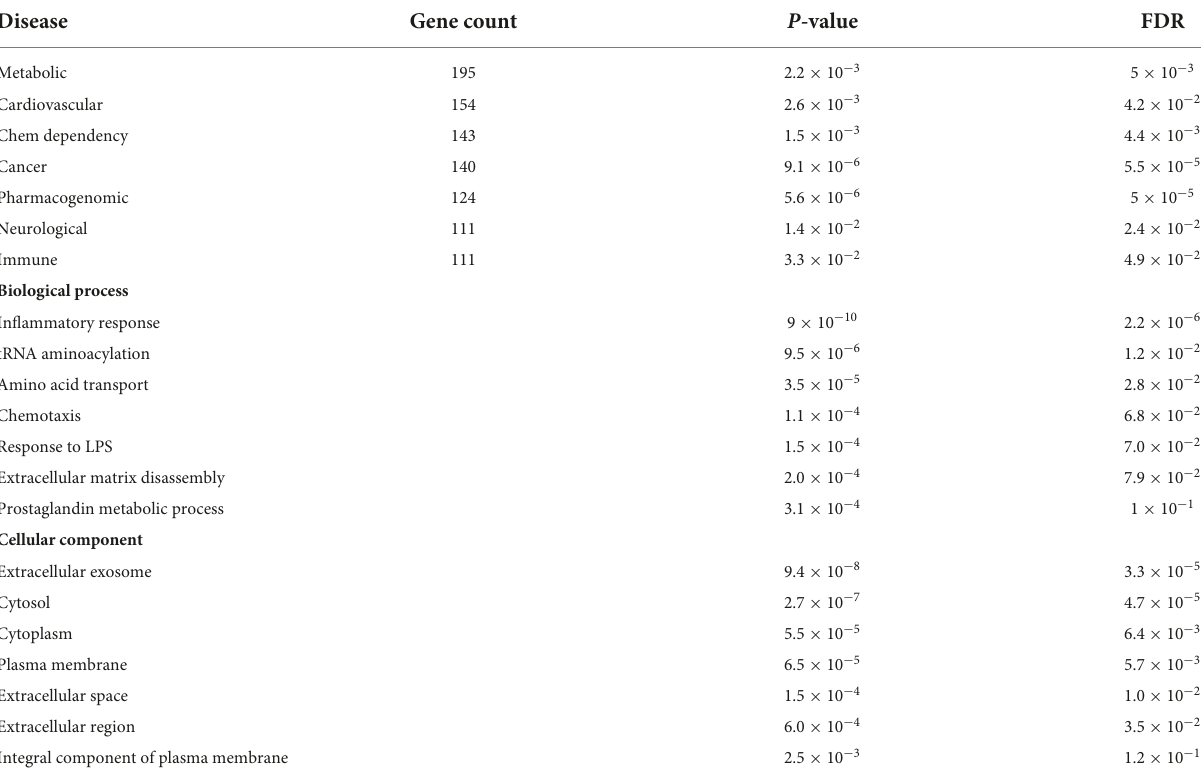
TABLE 1 Functional gene ontology analysis of human macrophages with low TRIB3 expression.